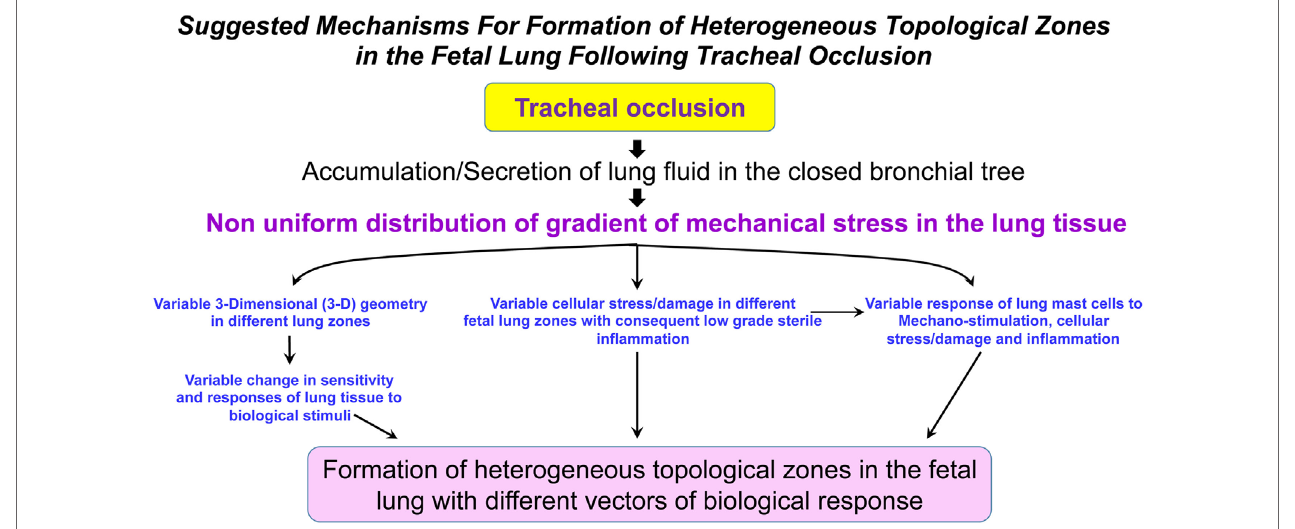
FiGURe 2 | Suggested mechanisms for formation of heterogeneous topological zones in the fetal lung following tracheal occlusion (TO). We propose that TO results in a non-uniform distribution of the mechanical stress gradient in the fetal lungs. This non-uniform mechanical stress will be accompanied by variable changes in the different lung zones with respect to 3-D geometry, cellular stress/damage, and lung mast cell response. Ultimately, the interplay between these factors will result in formation of heterogeneous topological zones in fetal lungs with different vectors of biological